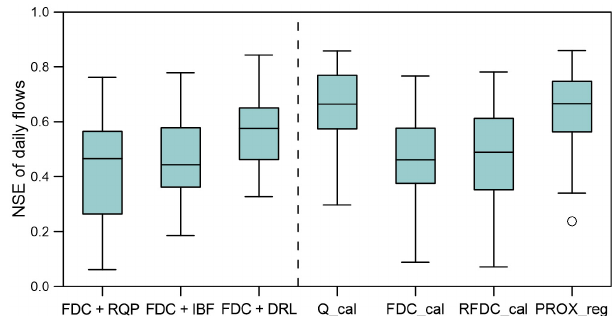
Figure 9. Predictive performance of the FDC calibrations ad- ditionally conditioned by R QP (FDC + RQP), I BF (FDC + IBF), and D RL (FDC + DRL) in comparison to the other modelling ap- proaches. Q_cal and FDC_cal refer to the hydrograph and the FDC calibration in gauged catchments respectively. Thirty-eight catch- ments with positive NSE for all the modelling approaches were used in the box